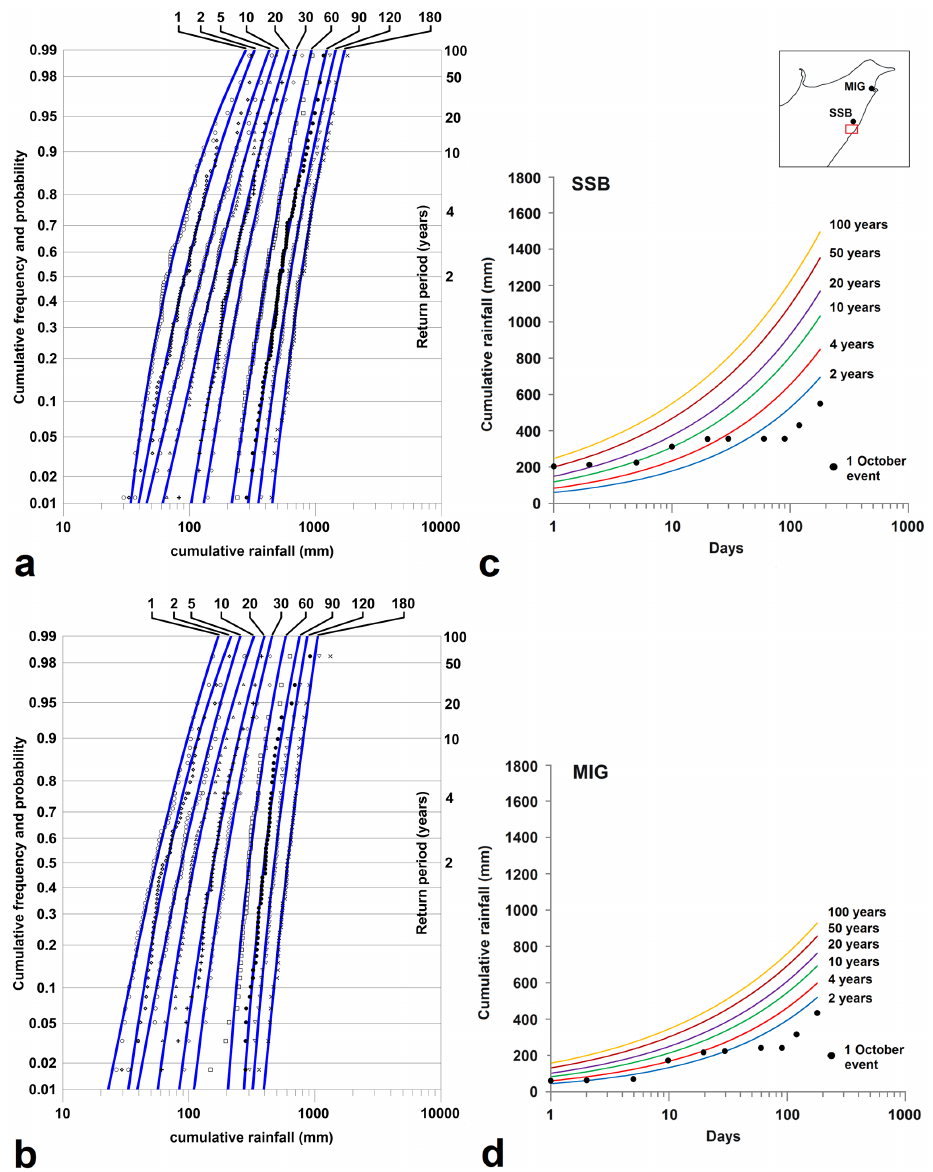
Figure 11. Cumulative frequency and probability according to GEV distribution for 1, 2, 5, 10, 20, 30, 60, 90, 120 and 180 days of cumulative rainfall for (a) Santo Stefano di Briga (SSB) and (b) Messina Istituto Geofisico (MIG) stations; (c–d) rainfall probability curves for return periods of 2, 4, 10, 20, 50 and 100 years for the same stations, whose location is shown in the sketch on the upper right (the red square represents the study